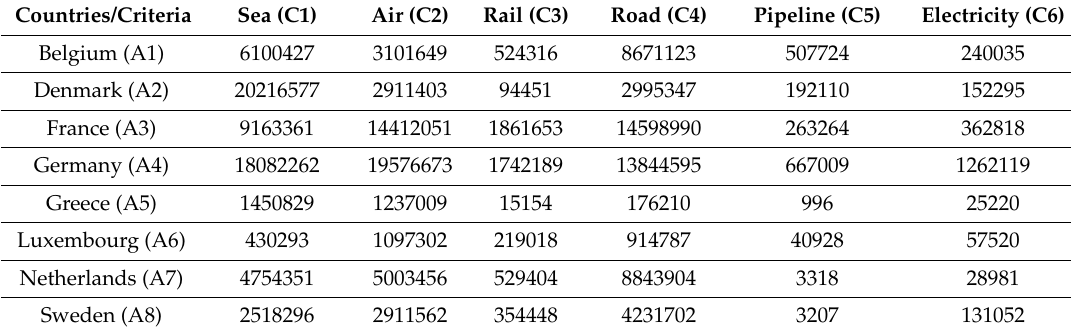
Table 5. Selected Data of Transport Import for the EU by 2016 (US Dollar,